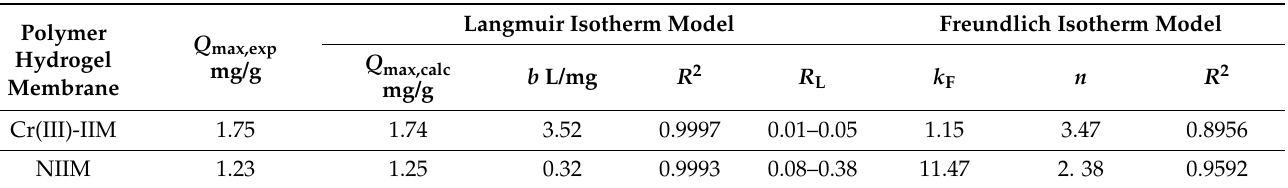
Table 2. Experimental adsorption capacity values and Langmuir and Freundlich isotherm parameters obtained by linear fitting for the Cr(III)-IIM and NIIM at temperature of 40 ◦